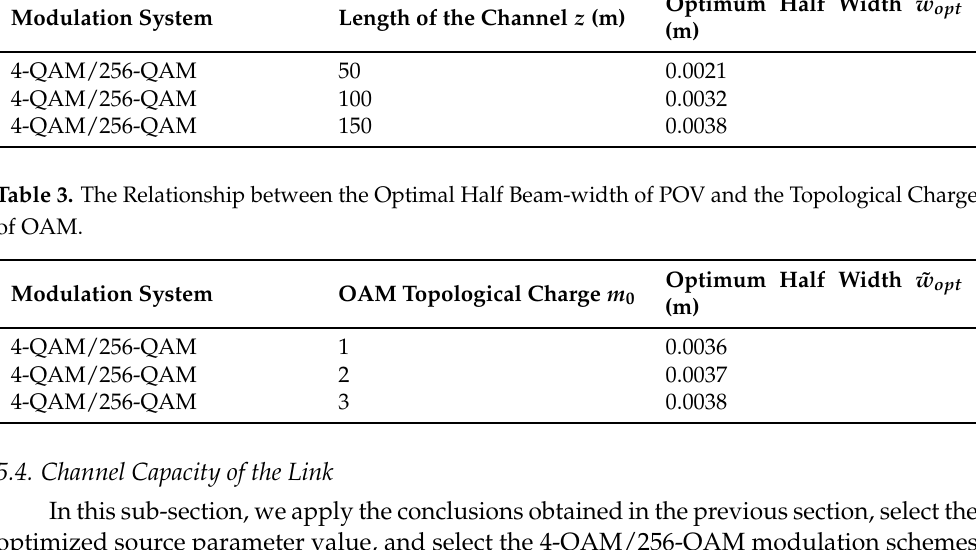
Table 2. The Relationship between the Optimal Half-width of the POV and the Channel Length. Modulation System Length of the Channel z (m)